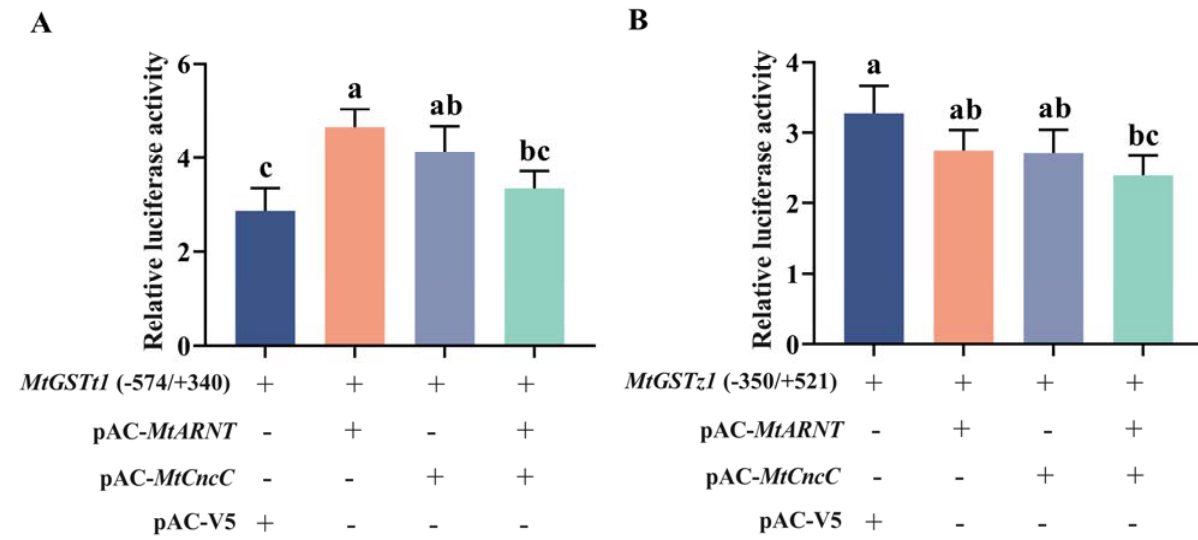
Figure 6. Relative luciferase activity in cells transfected with the MtGST promoters, MtCncC and MtARNT. ( A ) MtGSTt1 ( − 574/+340) promoter; ( B ) MtGSTz1 ( − 350/+521) promoter. Each promoter activity was measured in the absence of protein (promoter + empty pAC-V5 basic vector), in the presence of a protein (MtARNT or MtCncC) or in the presence of two proteins (MtCncC and MtARNT). Each value is presented as the mean ± SD of three replicates, and lowercase letters show significant differences ( p < 0.05).